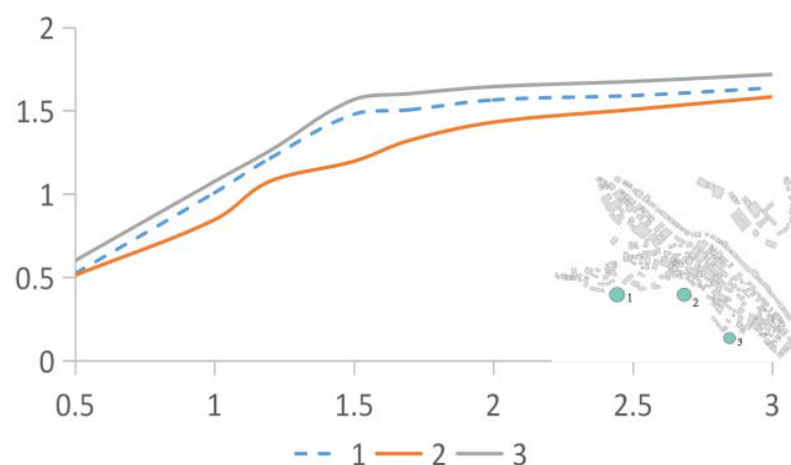
Figure 4. Deviation analysis of the 3 points at the air inlet.